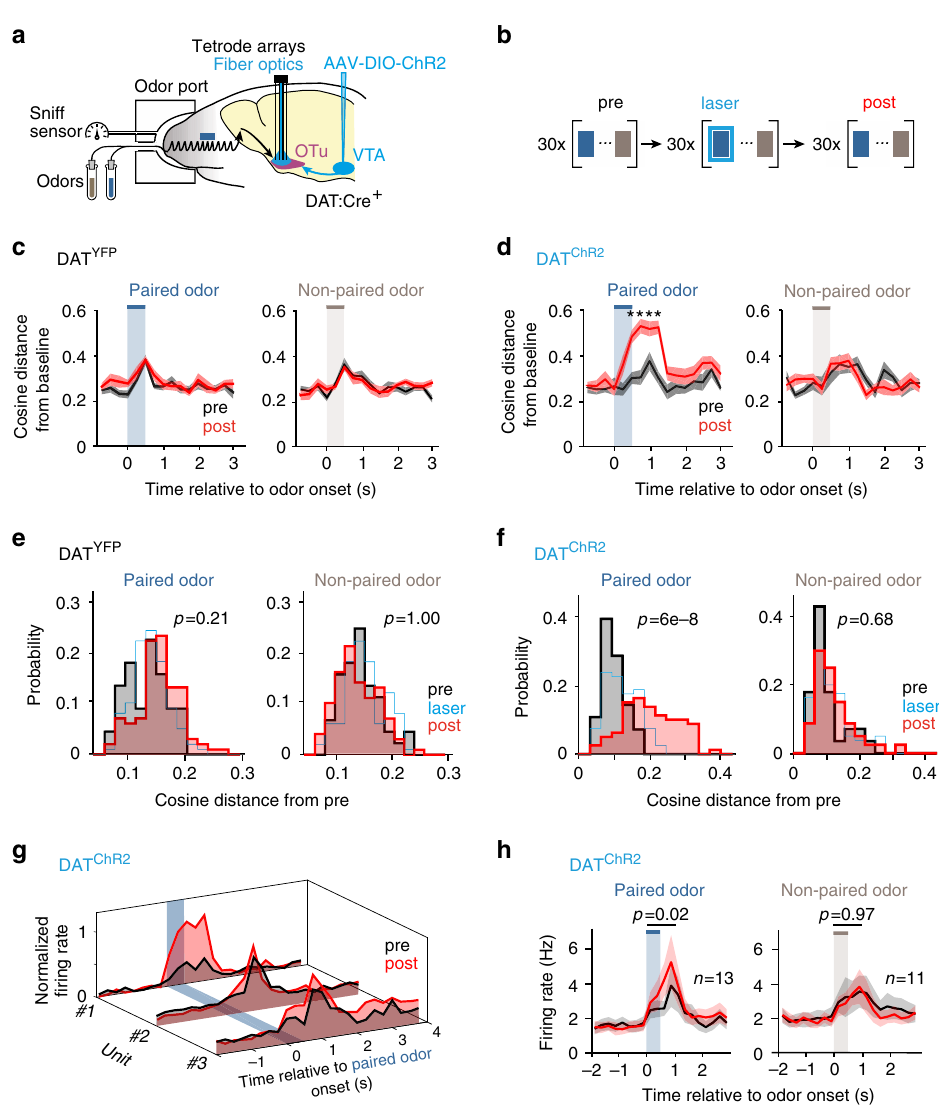
Fig. 1 Phasic DA modi fi es striatal population encoding selectively of the paired odor. a Two odors were applied for 0.5 s in pseudorandomized order to head- fi xed DAT ChR2 or DAT YFP mice. b During the ‘ pairing ’ phase, one odor was paired transiently with brief laser trains delivered to the recording site in the OTu to evoke phasic DA (pDA) release. c , d Cosine distance from baseline of the of the population vector for the two odors during the ‘ pre ’ and ‘ post ’ phases (displayed mean ± S.E.). Phasic DA pairing enhanced exclusively the paired odor response of ( d ) DAT ChR2 , but not ( c ) DAT YFP mice (two-sided